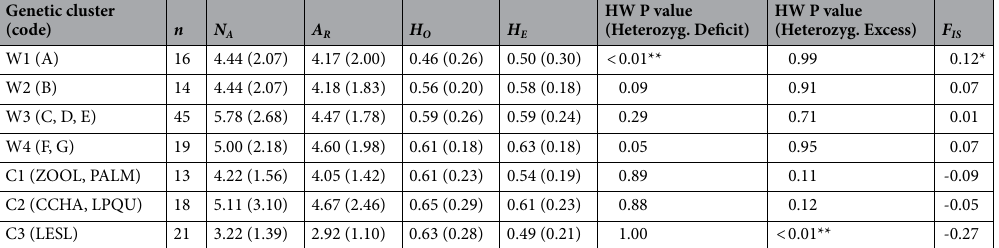
12 Zoological Park of Santa Cruz de la Sierra; Exposed to the public, not breeding; Unknown wild origin from poaching